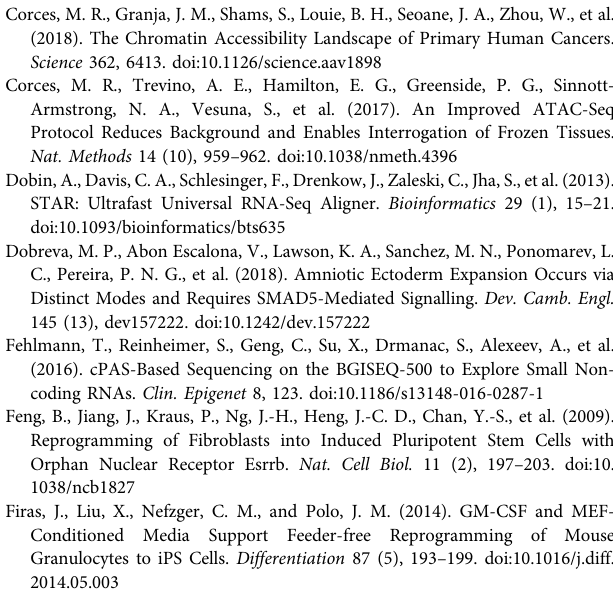
Supplementary Table S3 | Top 25 non-redundant motifs identi fi ed via HOMER. Supplementary Table S4 | Top 40 non-redundant motifs identi fi ed via Hint-ATAC. Supplementary Table S5 | Top 40 non-redundant motifs identi fi ed via